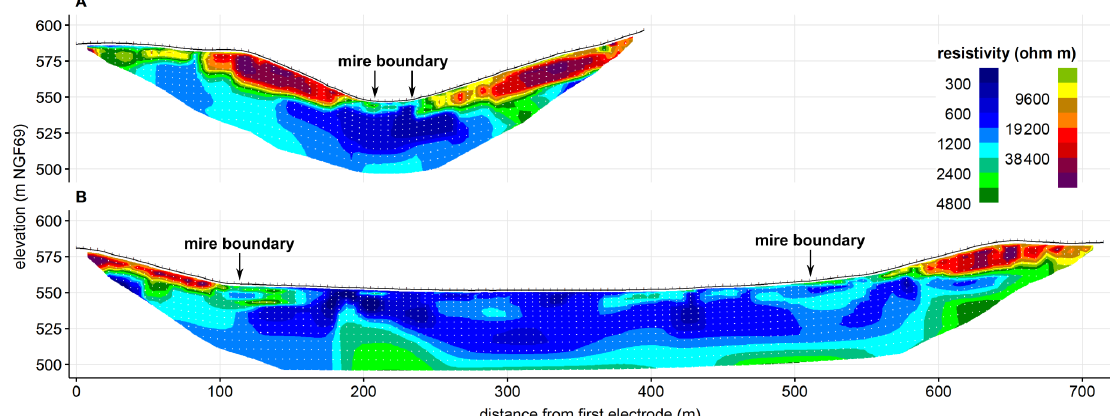
Figure 2. Electrical resistivity tomography images obtained after the inversion of apparent resistivity data acquired using a Schlumberger configuration. The survey was conducted using 80 electrodes for Profile A and 144 electrodes for Profile B, with an electrode spacing of 5m. The inversion was performed using the Res2Dinv software and a L1 norm optimisation, leading to RMSEs of 5.3% for Profile A and 2.2% for Profile B. White dots show the centres of model blocks, the black line the surface topography and the black vertical marks the electrode positions. The profile locations are shown in Fig.